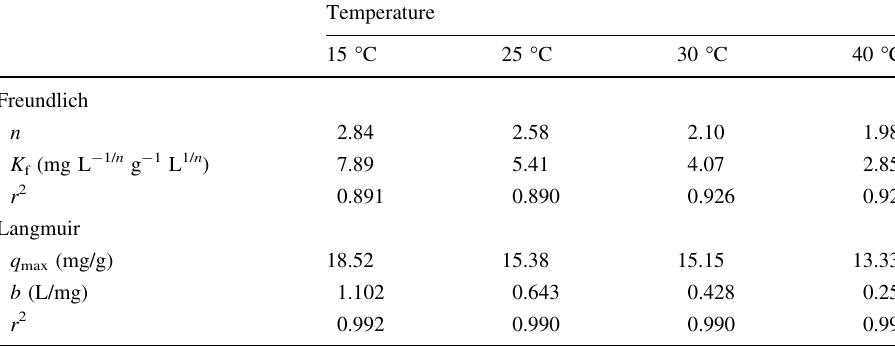
Table 2 Isotherm constants for diazinon adsorption onto pre- treated coffee waste